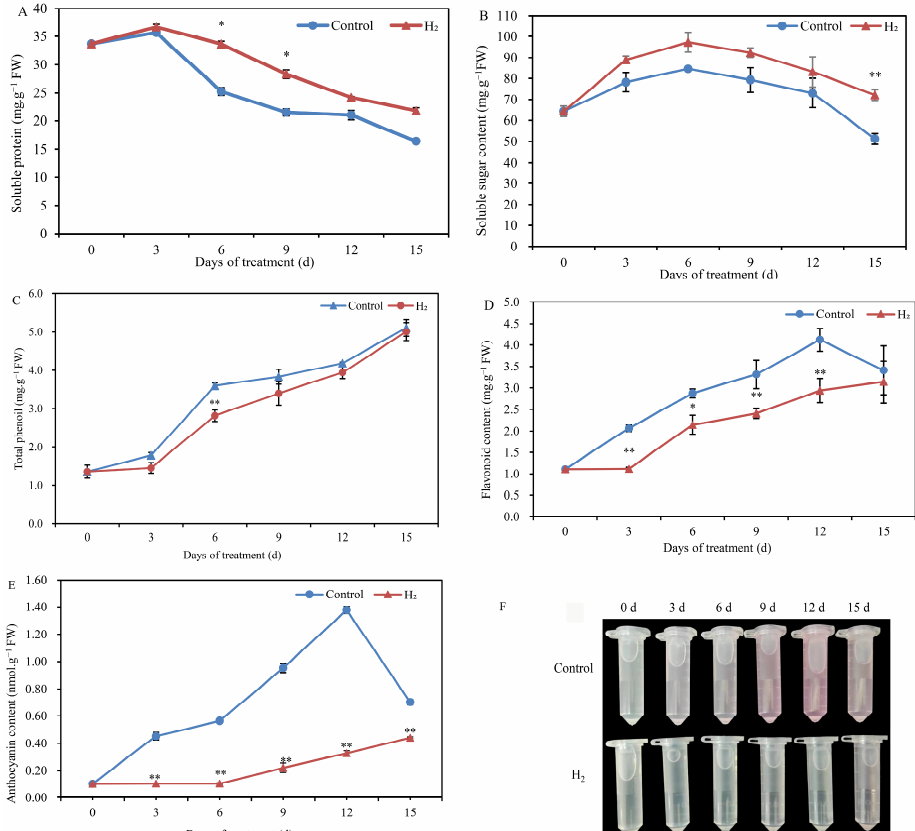
Figure 3. Changes in the contents of soluble protein ( A ), soluble sugars ( B ), total phenols ( C ), flavonoids ( D ), anthocyanidin ( E ) and anthocyanin extract solution color ( F ) of Lanzhou lily scales fumigated with or without H 2 during storage at room temperature for 15 days. The error bars indicate the means ± SE (n = 9 scales from each of three independent experiments). Values with asterisks are significantly different (* p < 0.05; ** p < 0.01) from the control treatment on the same day according to independent t -test. d: days.